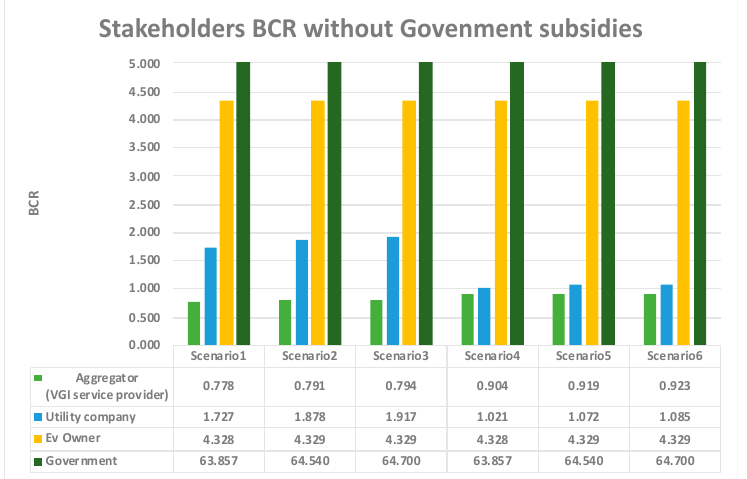
Figure 4. Stakeholders’ BCR without government subsidies.